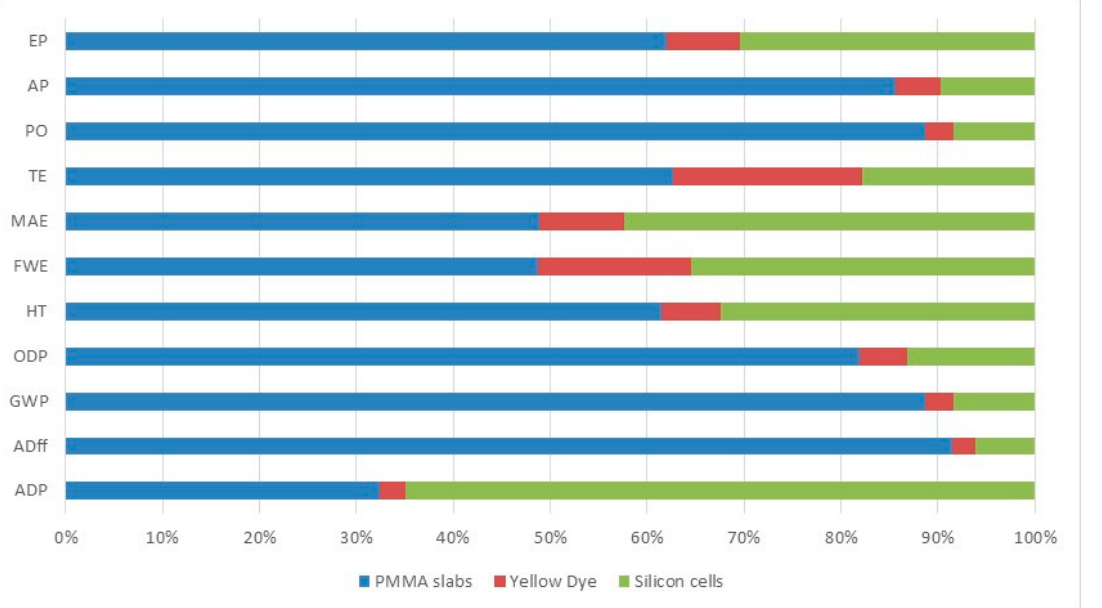
Table 3. Total impacts and credits of the EOL.